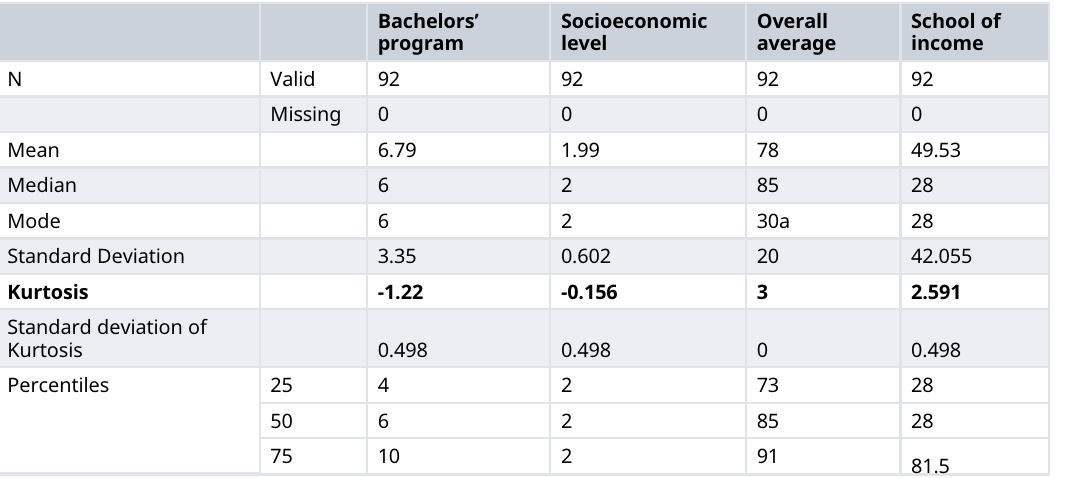
Table 2. Descriptive analysis of the most significant variables dropout to other